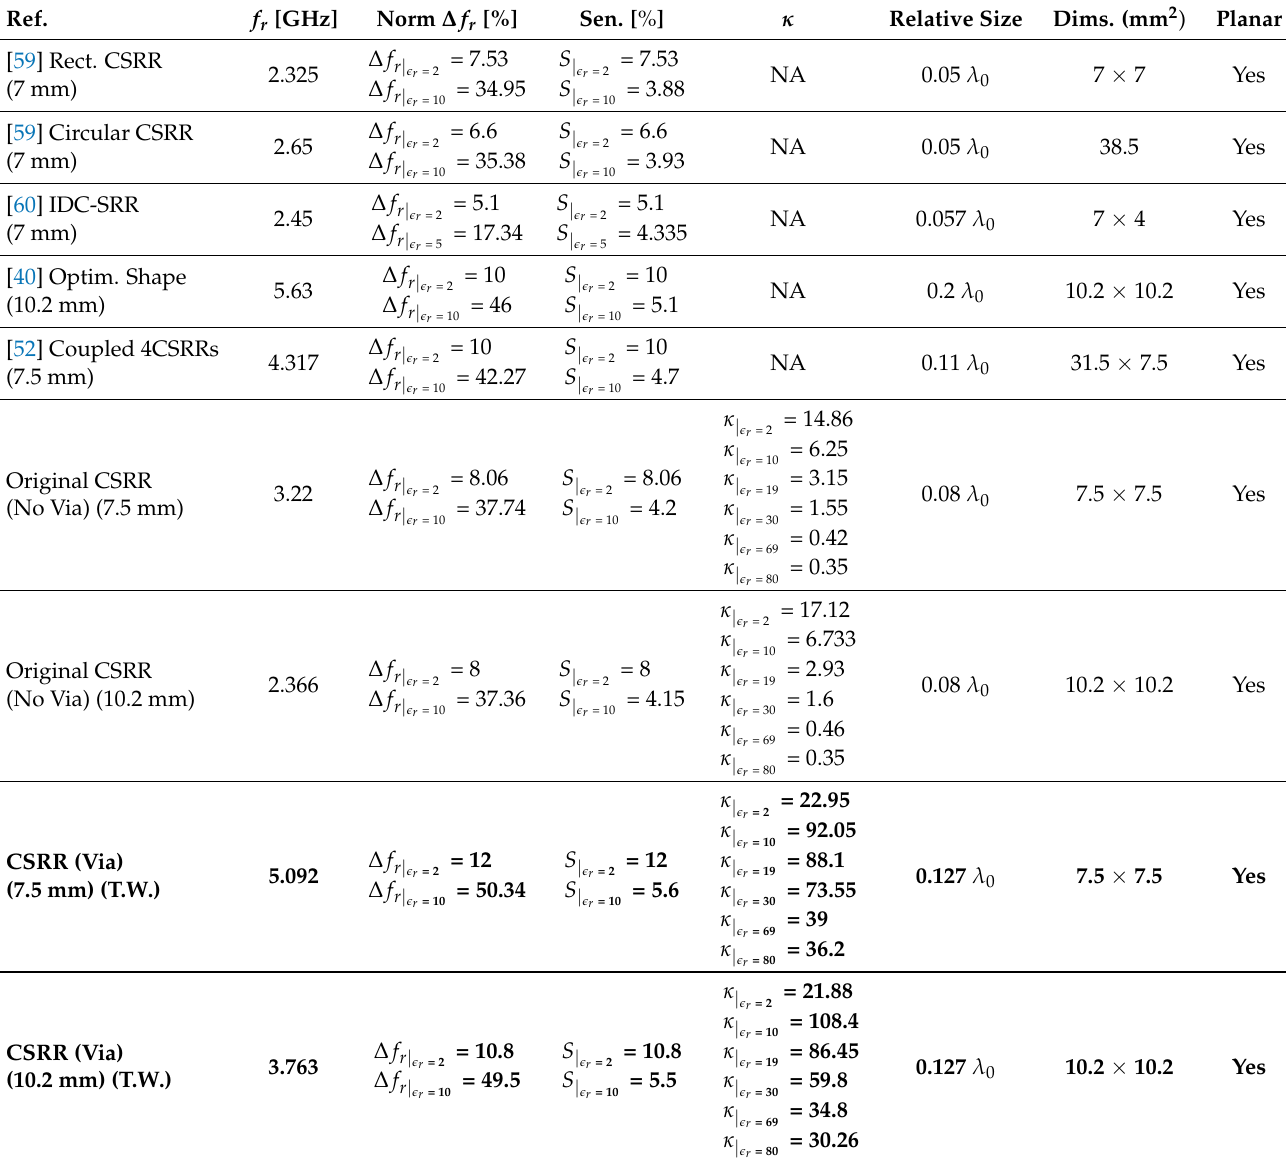
Table 3. Table of comparison: The state-of-the-art sensors and the original CSRRs.